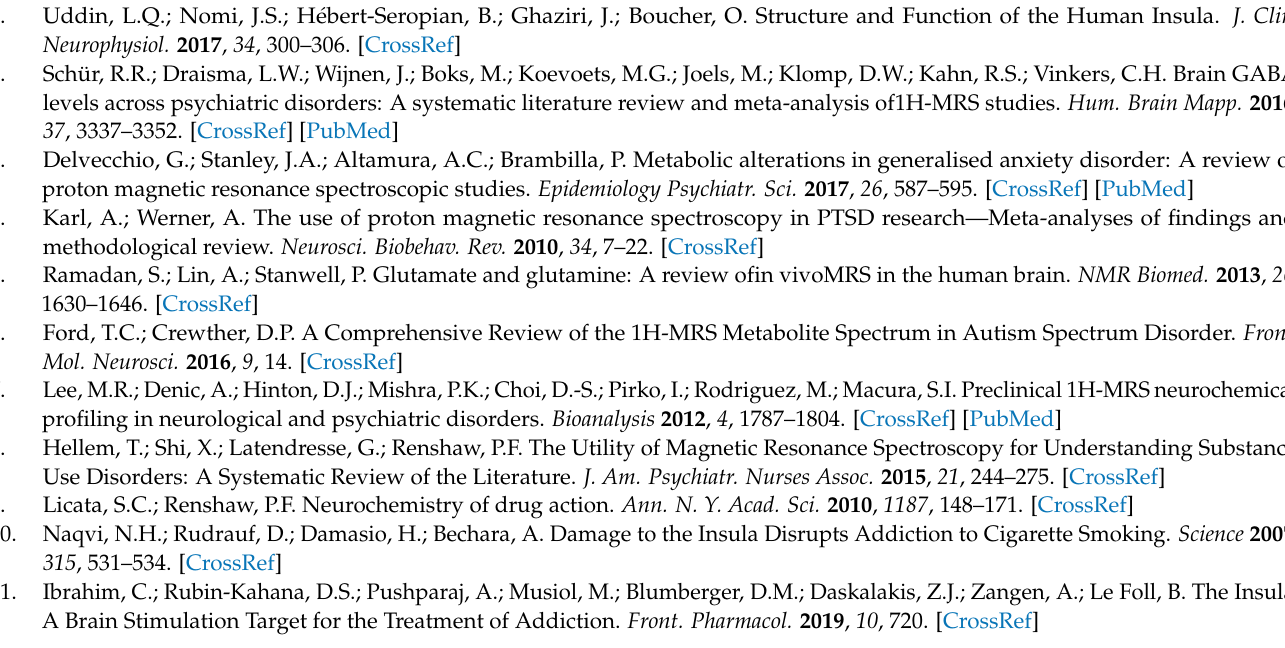
Supplementary Materials: The following are available online at https://www.mdpi.com/article/ Table S2: PRESS B2B and D2D Reproducibility Data, Table S3: Metabolite concentrations compared between male and female participants using Day2 scan averages. The concentrations were de- rived from MEGA-PRESS edit OFF scans. M = mean and SD = standard deviation are computed across